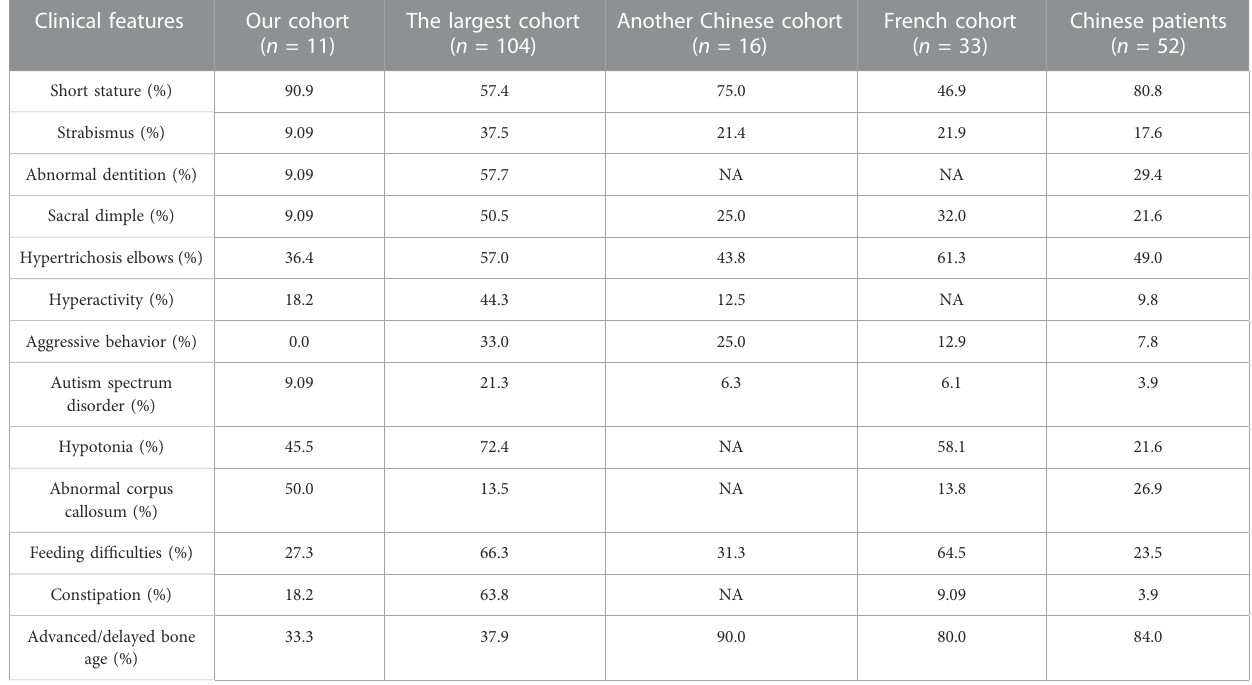
TABLE 2 Clinical features of different frequencies comparing with other WSS cohorts. Clinical